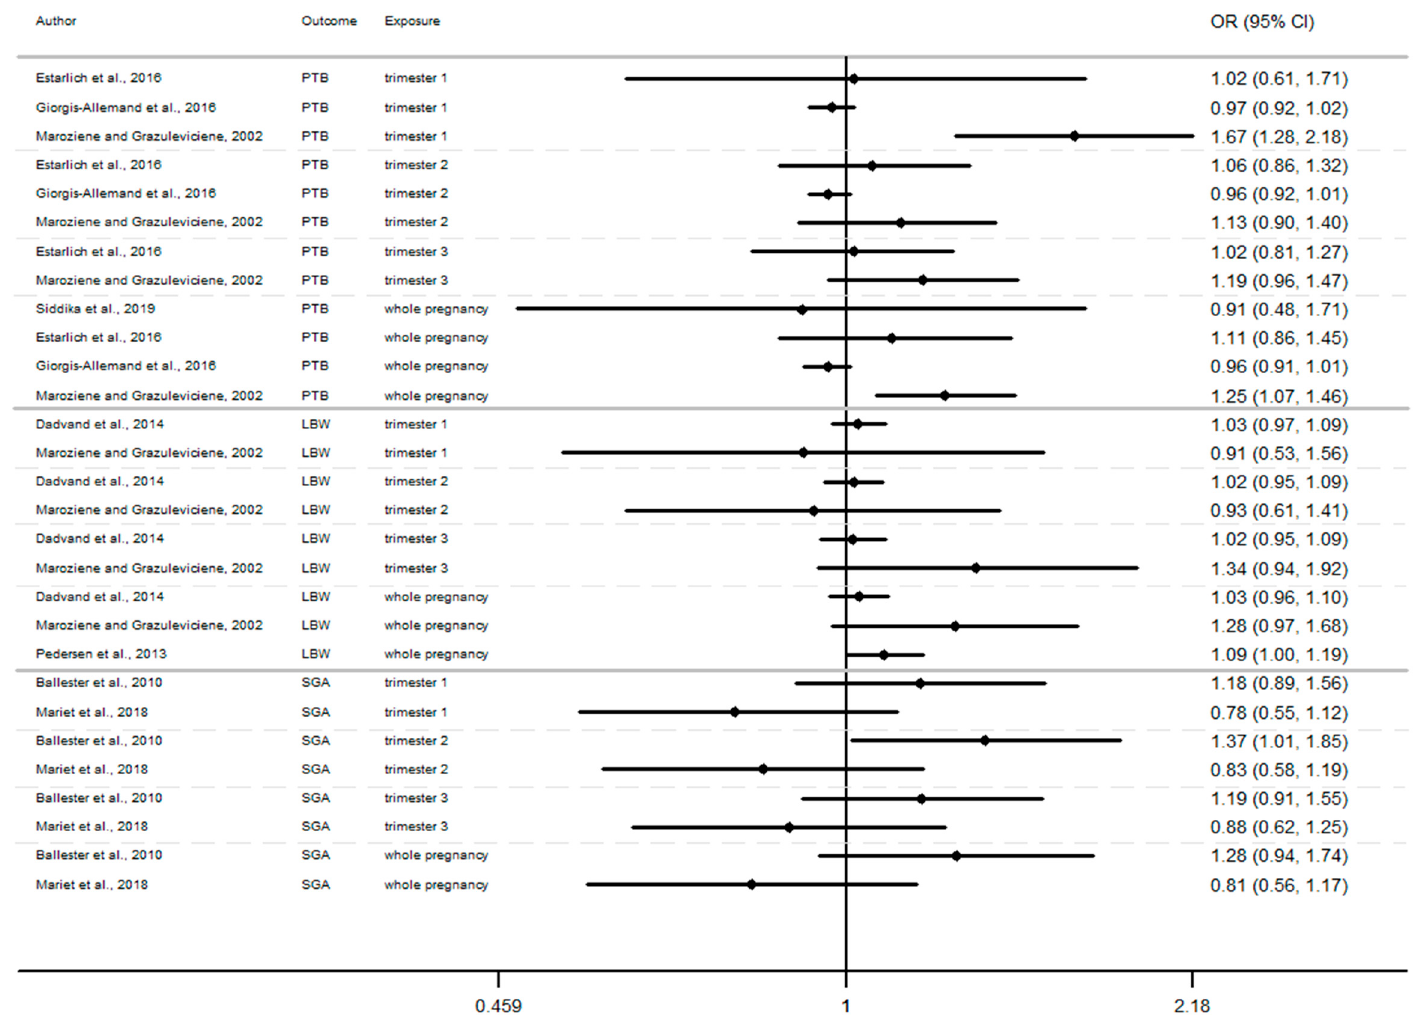
ff erent windows of exposure during 2 exposure during di